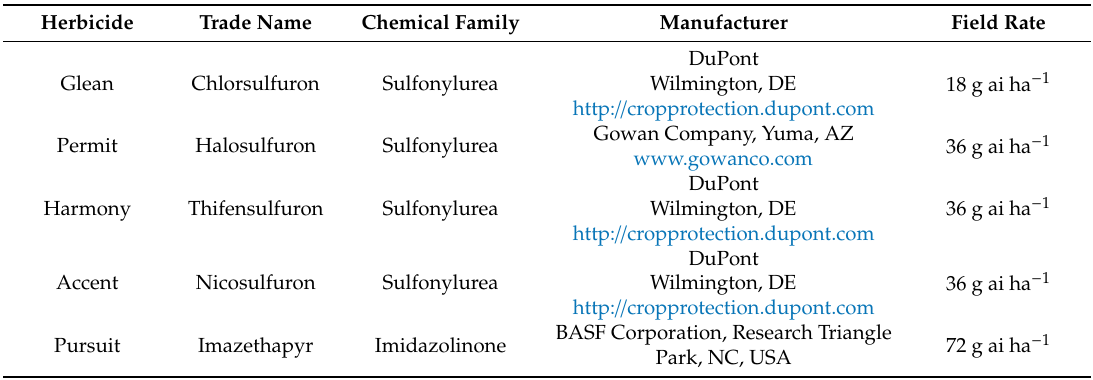
Table 1. List of herbicides used in the